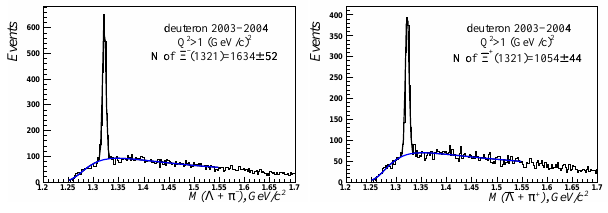
Fig. 3. Invariant mass distributions of Λπ − (left) and ¯ Λπ + (right) in the secondary